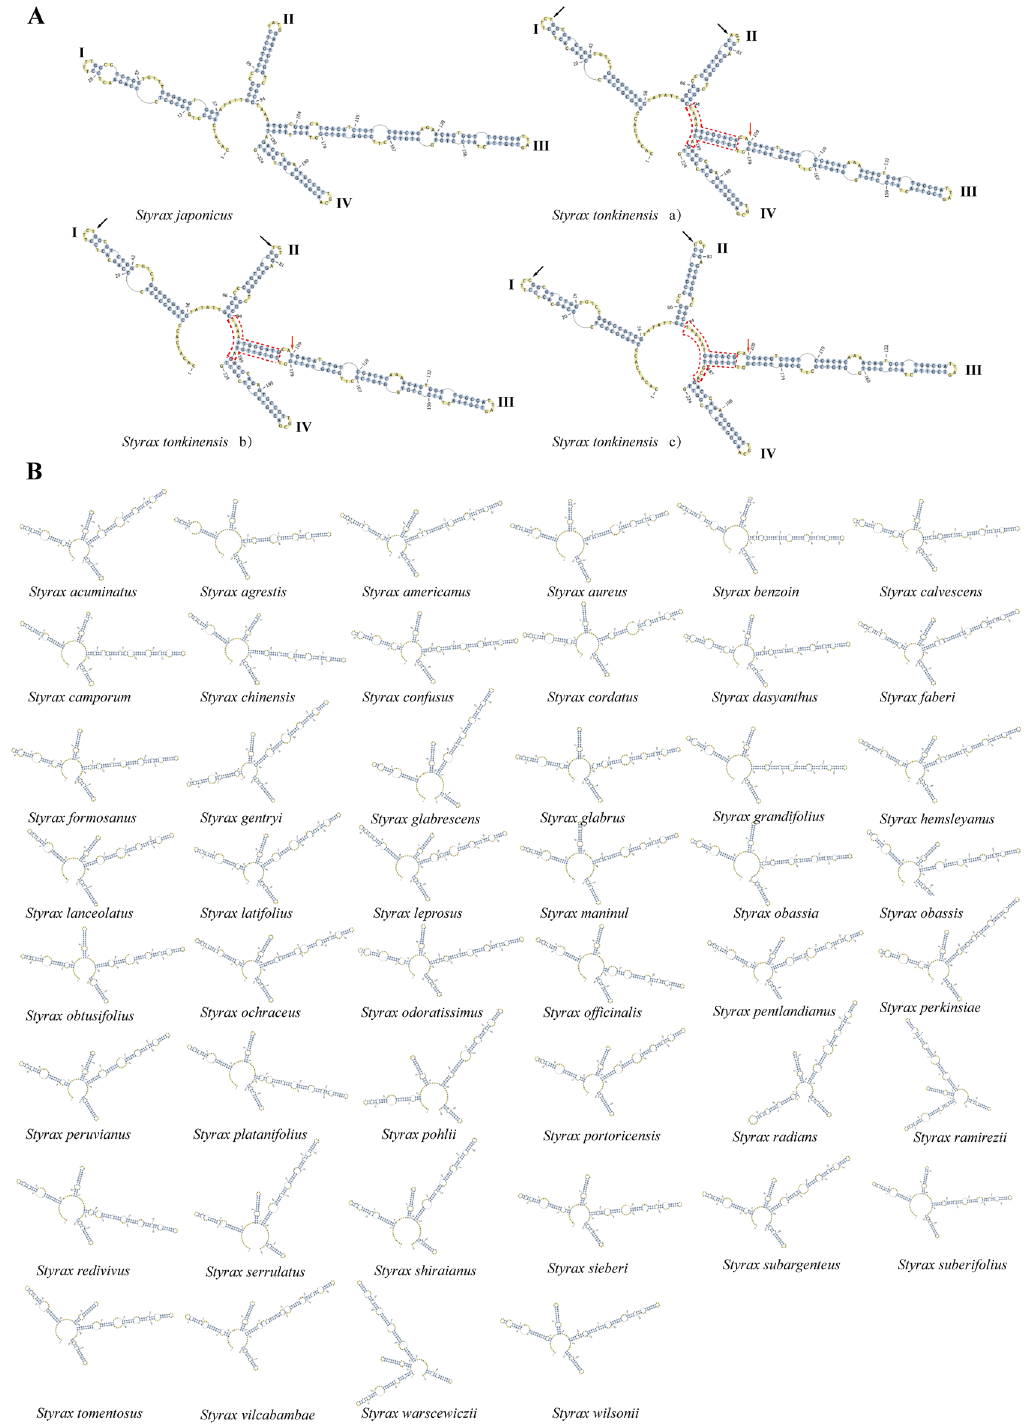
Figure 2. ( A ) Comparison of the secondary structure of ITS2 between benzoin samples from S. tonkinensis and S. japonicus . S. tonkinensis secondary structures a), b), and c) were all slightly different. Arrows indicate the sites of hCBCs (red) and different base sites (black), and the red dashed boxes represent the different base pairs in helix III of S. tonkinensis . ( B ) The secondary structures of ITS2 in 46 taxa analyzed in this study, except for S. tonkinensis and S. japonicus . The species name is marked below each